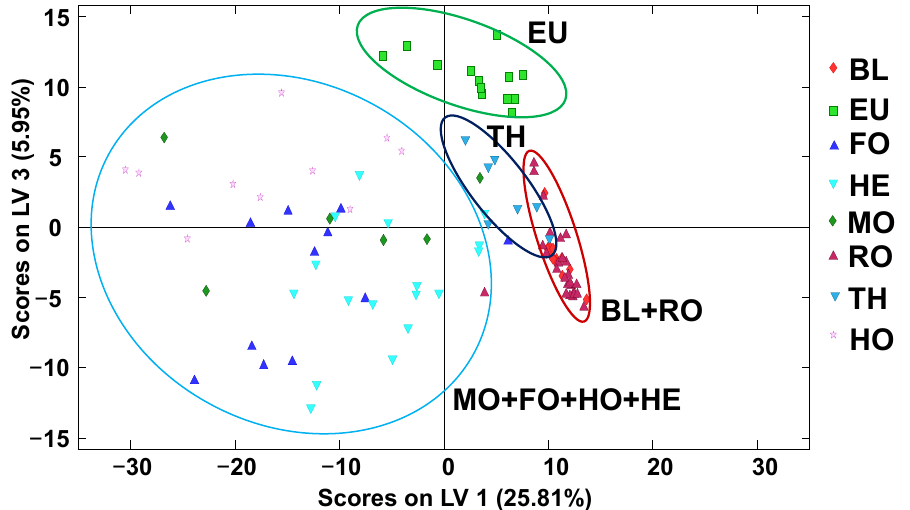
Figure 3. Score plot of LV1 vs. LV3 by PLS–DA when using non-targeted LC–HRMS fingerprints as honey chemical descriptors for botanical variety classification (three LVs were used to build the model). BL: orange/lemon blossom; EU: eucalyptus; FO: forest; HE: heather; HO: holm oak; MO: mountain; RO: rosemary; TH: thyme. QCs and multifloral honeys were not considered.